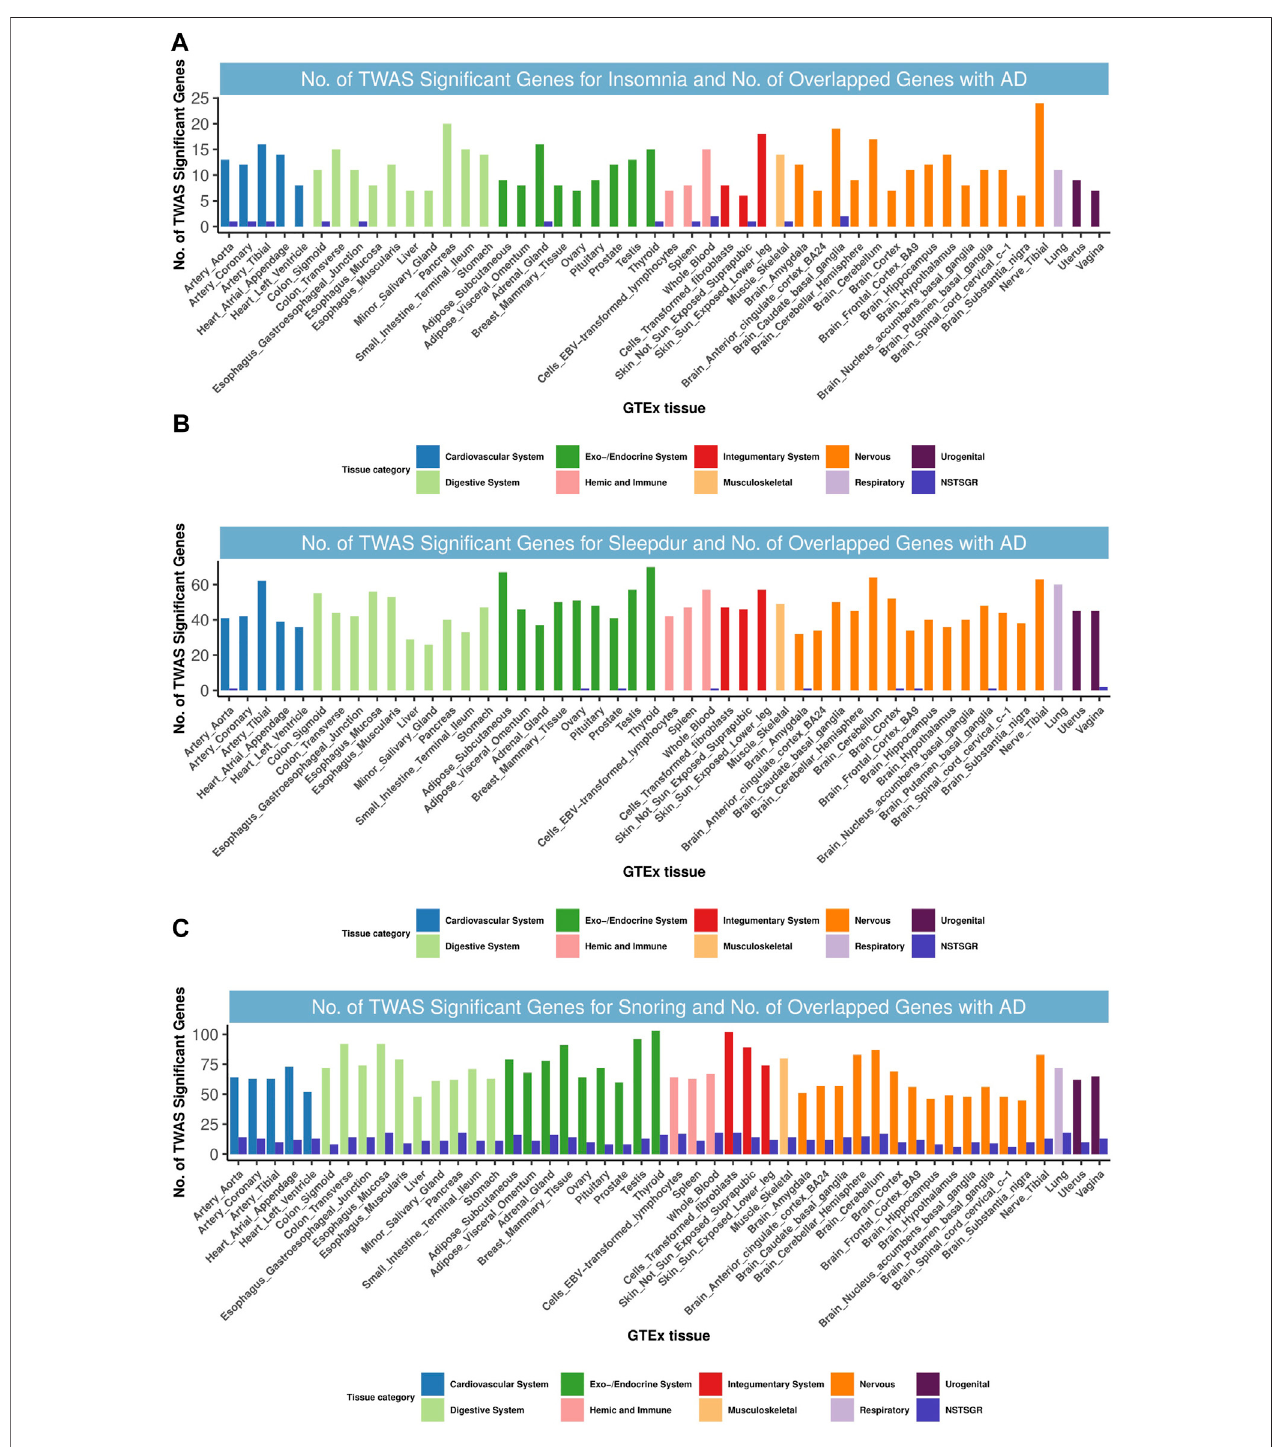
FIGURE 6 | Numbers of signi fi cant genes related with insomnia, sleepdur, and snoring and the number of shared genes with AD. Signi fi cant genes were identi fi ed by P BH < 0.05. GTEx, genotype-tissue expression project; GWAS, genome-wide association studies; TWAS, transcriptome-wide association study; NSTSGR, number of shared TWAS-signi fi cant genes with AD; AD, Alzheimer ’ s disease; Sleepdur, sleep duration. (A) : No. of TWAS-signi fi cant genes for insomnia and No. of overlapped genes with AD. (B) : No. of TWAS-signi fi cant genes for Sleepdur and No. of overlapped genes with AD. (C) : No. of TWAS-signi fi cant genes for snoring and No. of overlapped genes with AD